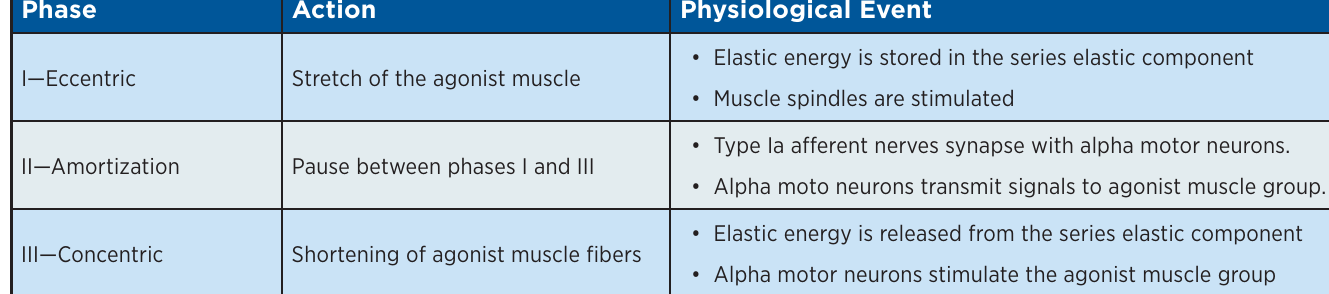
Figure 5-1. Stretch-Shortening Cycle